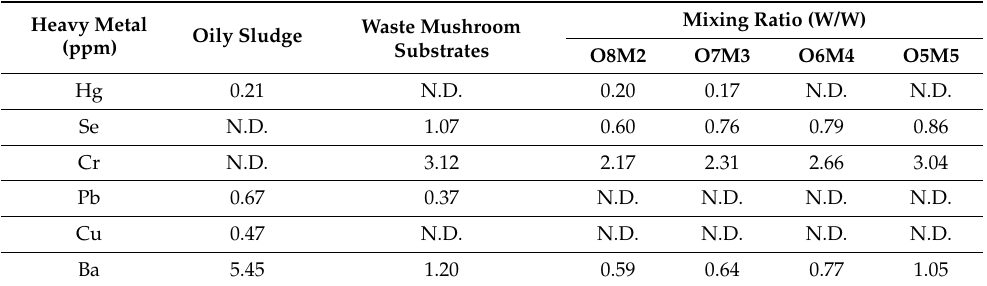
Table 4. Heavy metal analysis of RDF produced by oily sludge and waste mushroom substrates. Heavy Metal Oily Sludge Waste Mushroom (ppm)